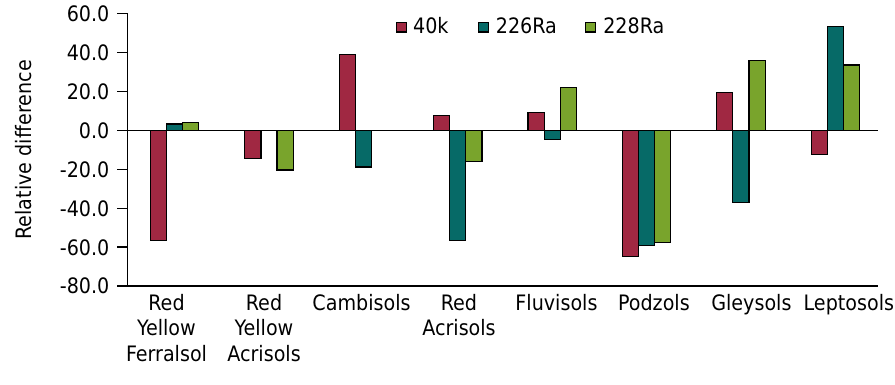
Figure 3. Relative deviation of QRVs for 40 K, 226 Ra, and 228 Ra activity contents for each soil class with respect to the single QRV for all soil